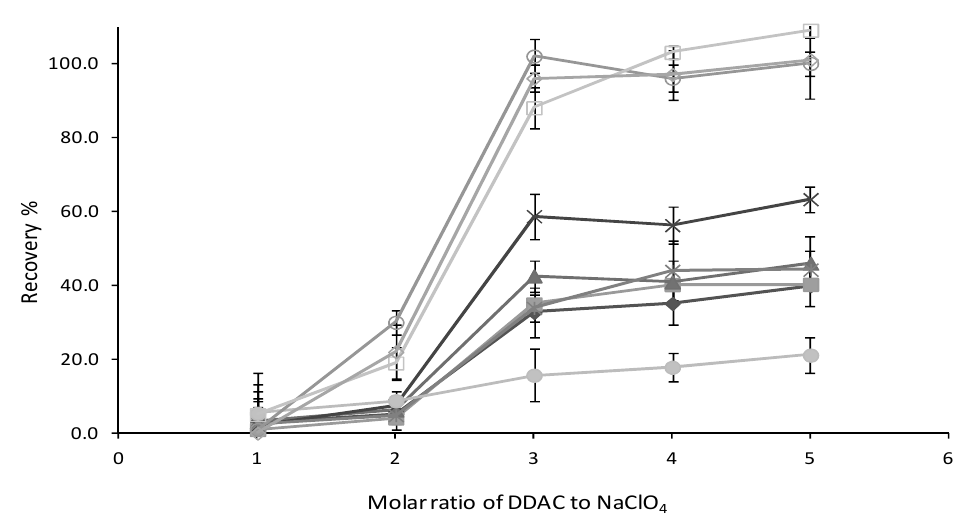
Figure 5. Impact of DDAC to NaClO 4 molar ratio on the recovery of the target analytes. Method parameters: sample volume—10 mL, DDAC concentration—1%, Fe 3 O 4 amount—5 mg.